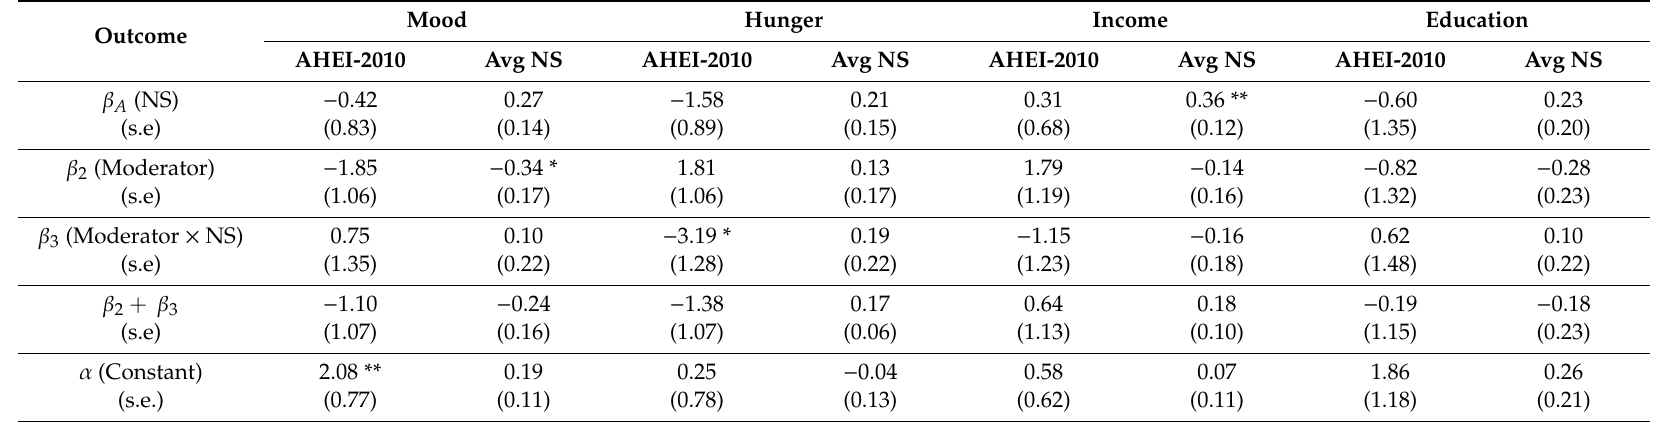
Table A7. Regression with moderator analyses ( N = 287, n = 146).